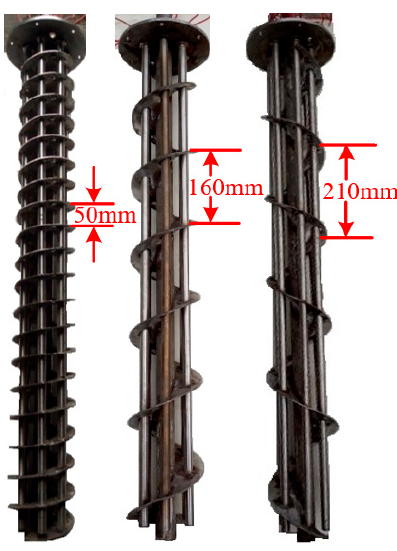
Figure 3. Heat transfer structure of heaters.